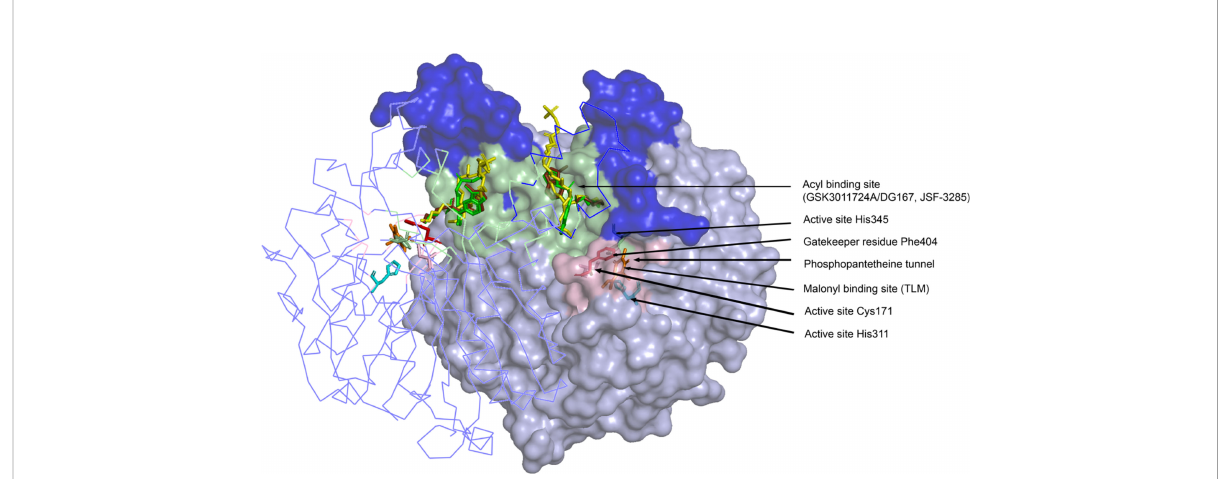
FIGURE 3 Crystal structure of the KasA dimer with inhibitors bound (GSK3011724A/DG167, JSF-3285, TLM) at different binding sites. The monomer on the left is represented as a ribbon tracing the alpha carbons and the monomer on the right is depicted as a surface. The dark blue surface indicates the cap region of KasA excluding the acyl channel whereas the light blue surface indicates the core domain; Light green surface, acyl binding site; pink surface, malonyl binding site; yellow sticks; phospholipid bound to KasA (PDB ID 4C6W); green sticks; DG167 (PDB ID 5W2P); brown sticks; JSF-3285 (PDB ID 6P9L); orange sticks; TLM (PDB ID 4C6U); pink sticks, Cys171; red sticks, Phe404; cyan sticks, His 311 and His 345. For clarity, only the KasA dimer from PDB ID 6P9L is